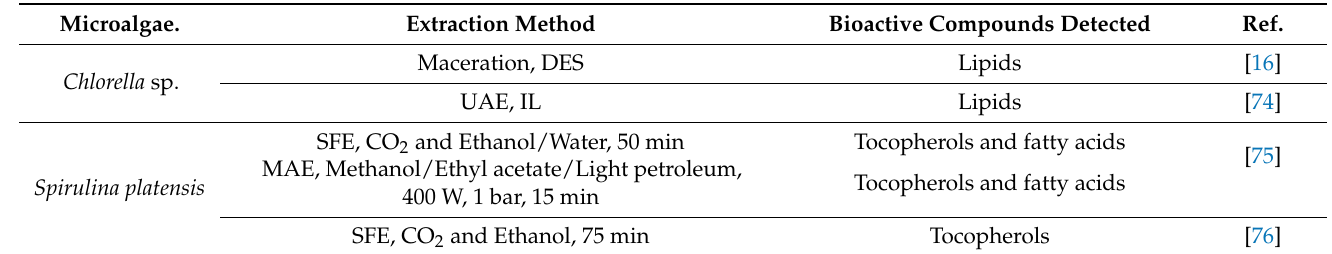
Table 8. Summary of different studies that have been conducted for the extraction of bioactive compounds from different species of